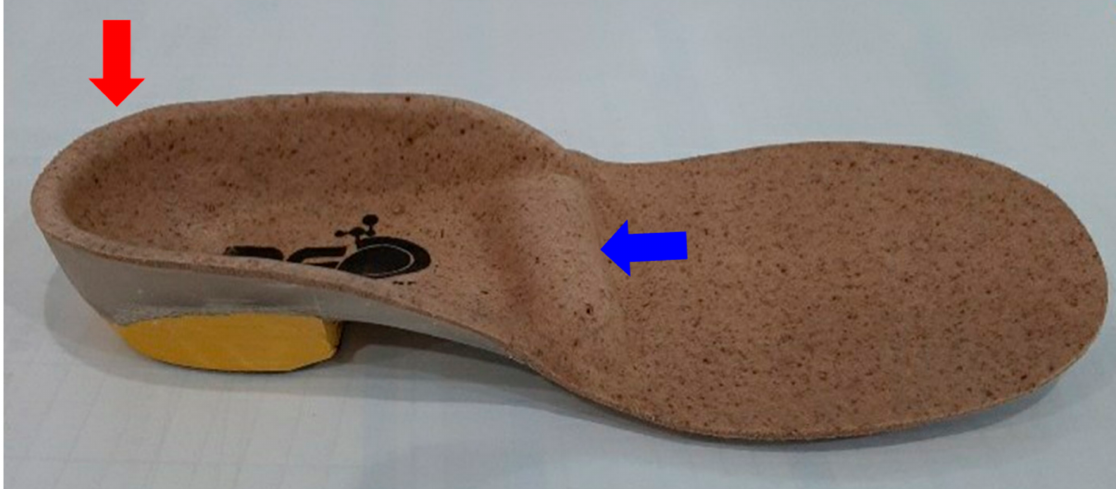
Figure 2. Insole with a metatarsal inhibition bar (blue arrow) and a deep heel cup (red